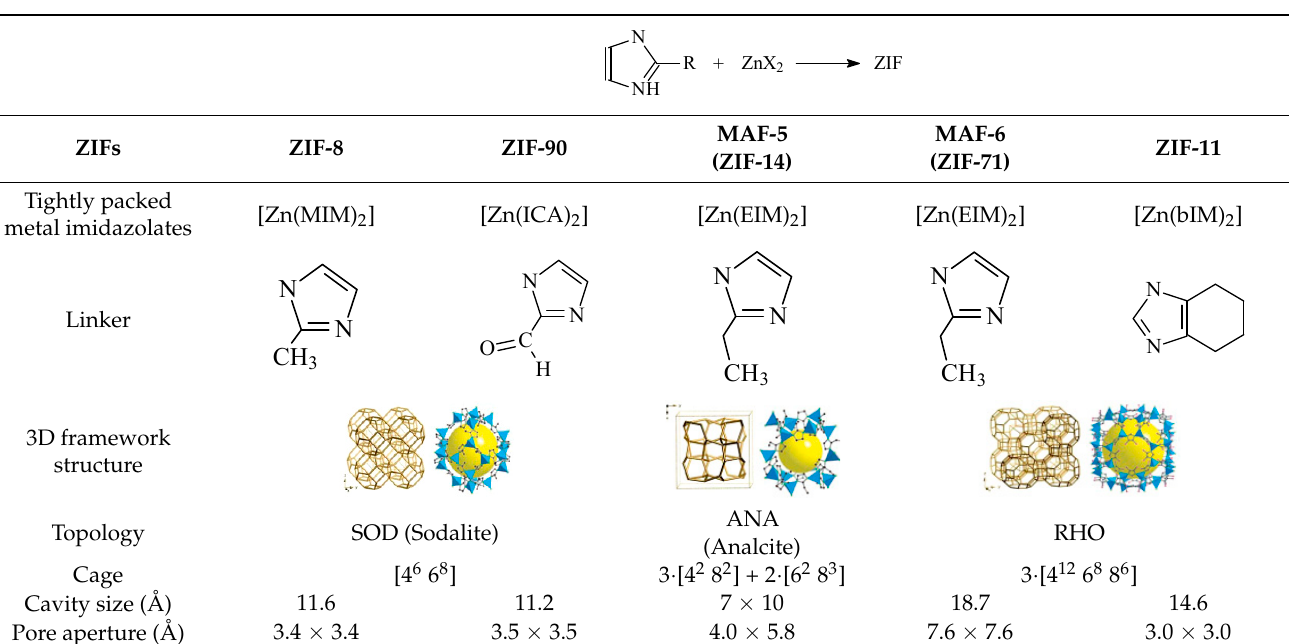
Table 1. Structural properties of Zn ‐ ZIFs 1 .